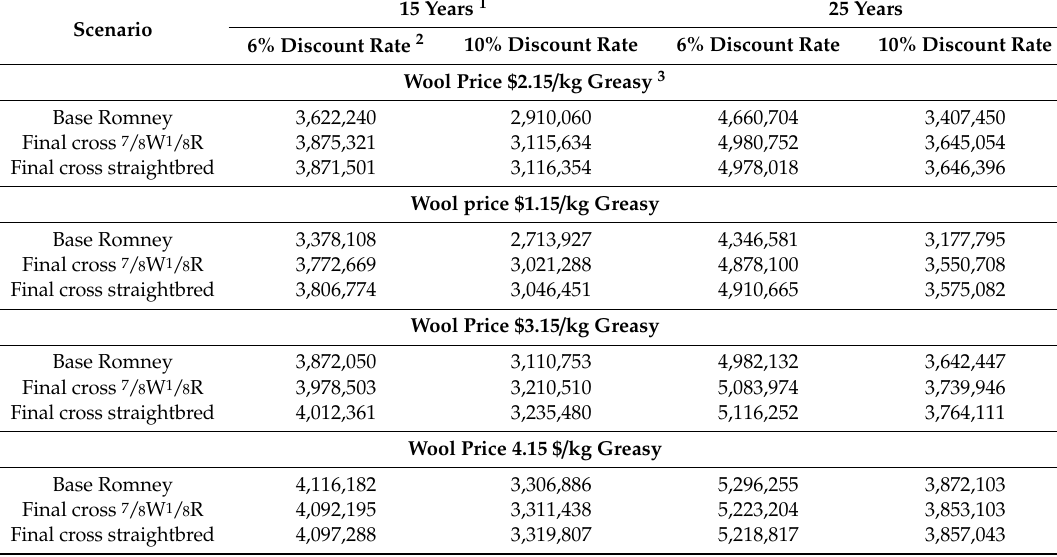
Table 6. Net present values of annual farm cash operating surplus (sheep and beef enterprises combined) of the maintenance of the status quo Romney flock compared with the grading up transition from Romney to a desired final cross of either 7 / 8 W 1 / 8 R or straightbred. Net present analyses were also conducted for each scenario with varying farmgate wool